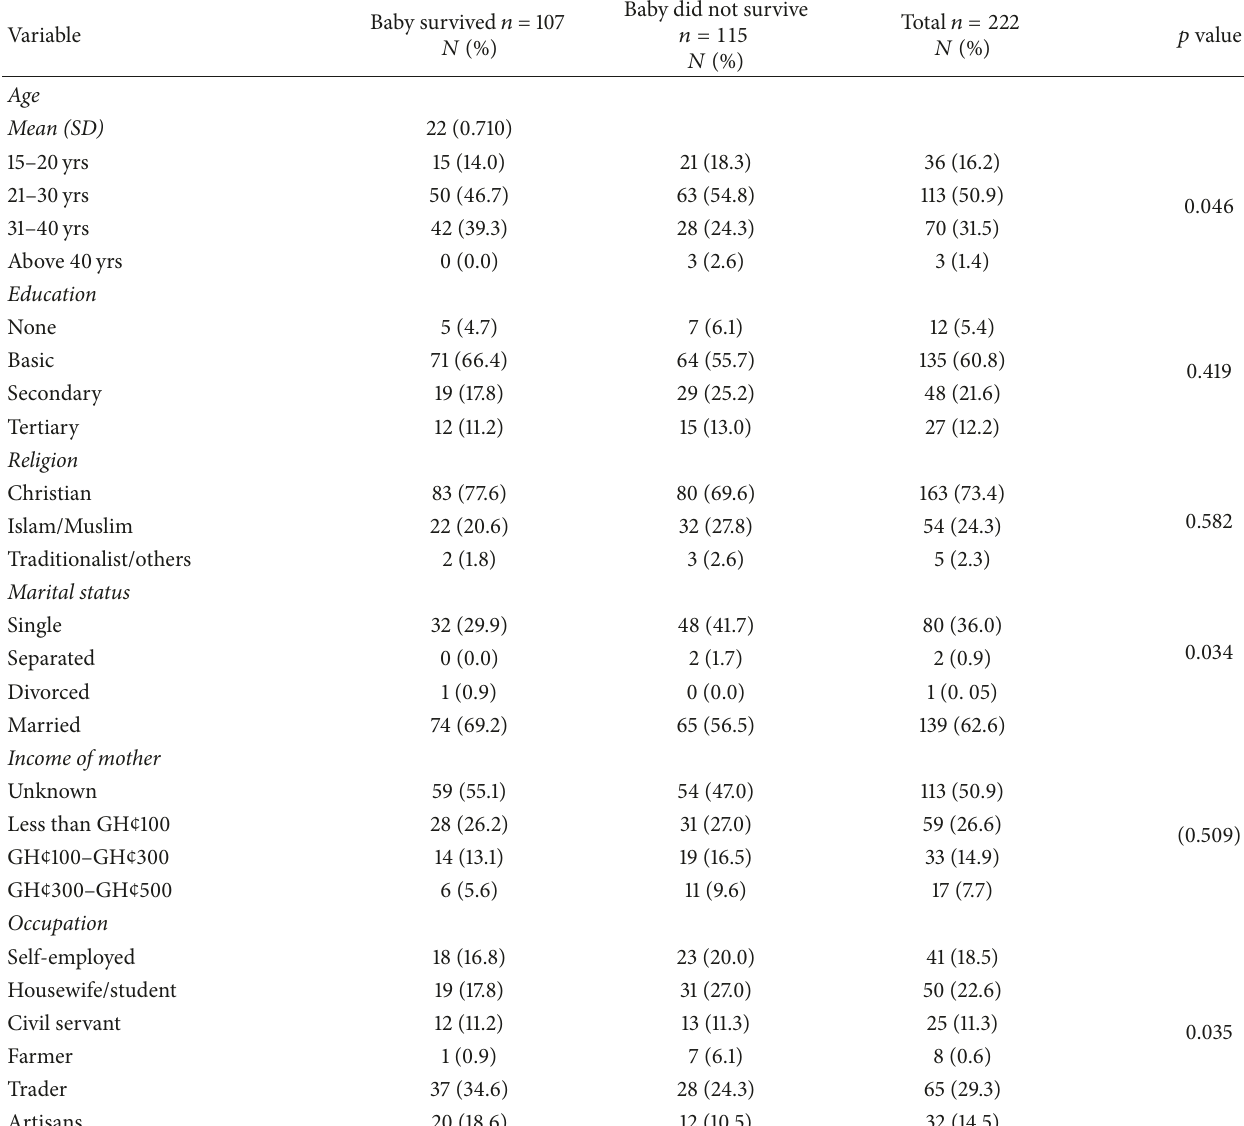
Table 1: Background characteristics of the mothers of children who died and those who